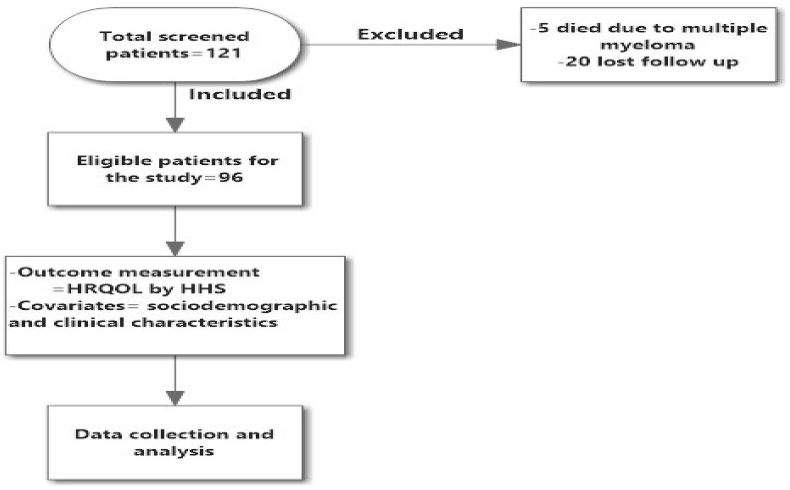
Study flow chart.